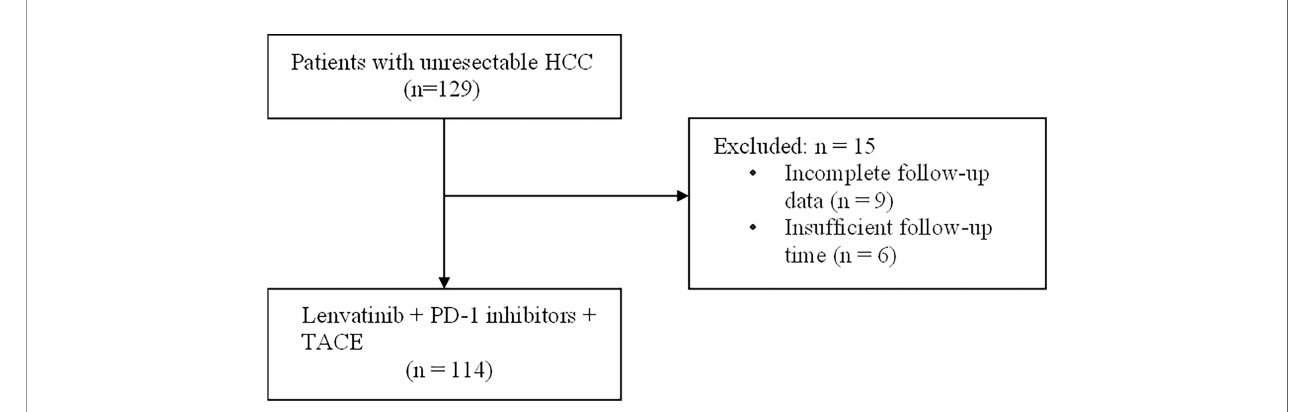
FIGURE 1 | Flowchart of the patient selection process. HCC, hepatocellular carcinoma; PD-1 inhibitors, programmed death receptor-1 signaling inhibitors; TACE, transarterial